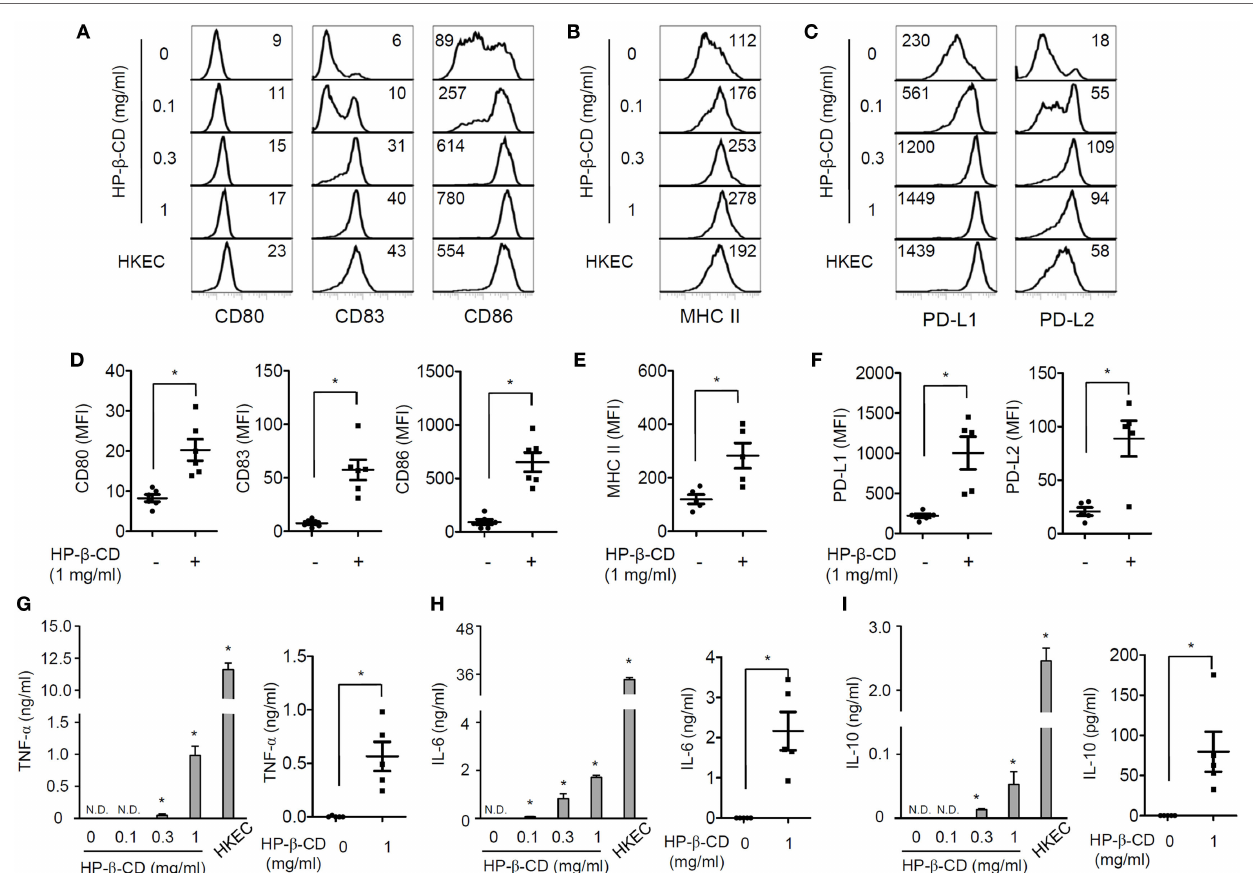
FigUre 1 | hP- β -cD induces maturation of human monocyte-derived Dcs . Human CD14 + monocytes (2 × 10 6 cells/ml) were differentiated into immature DCs in the presence of GM-CSF and IL-4 for 6 days. The monocyte-derived DCs (2.5 × 10 5 cells/ml) were stimulated with HP- β -CD (0, 0.1, 0.3, or 1 mg/ml) in the presence of GM-CSF and IL-4 for 24 h. (a–F) Expression of (a,D) CD80, CD83, and CD86, (B,e) MHC class II, and (c,F) PD-L1 and PD-L2 was analyzed by flow cytometry. The number on each histogram indicates MFI of the DCs. (D–F) The scatter plots below the histograms indicate the average MFI of DCs ± SEM for each molecule ( n = 5). The levels of (g) TNF- α , (h) IL-6, and (i) IL-10 in the DC culture supernatants were measured by ELISA. The scatter plots on the right side of each bar graph indicate the mean concentrations ± SEM of the cytokines ( n = 5). HKEC (1 × 10 7 CFU/ml) was used as a positive control. Statistical differences between compared groups were analyzed by paired Student’s t -test. N.D., not detected; * P < 0.05.